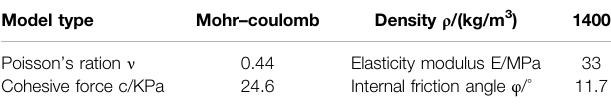
TABLE 3 | Soil parameters.